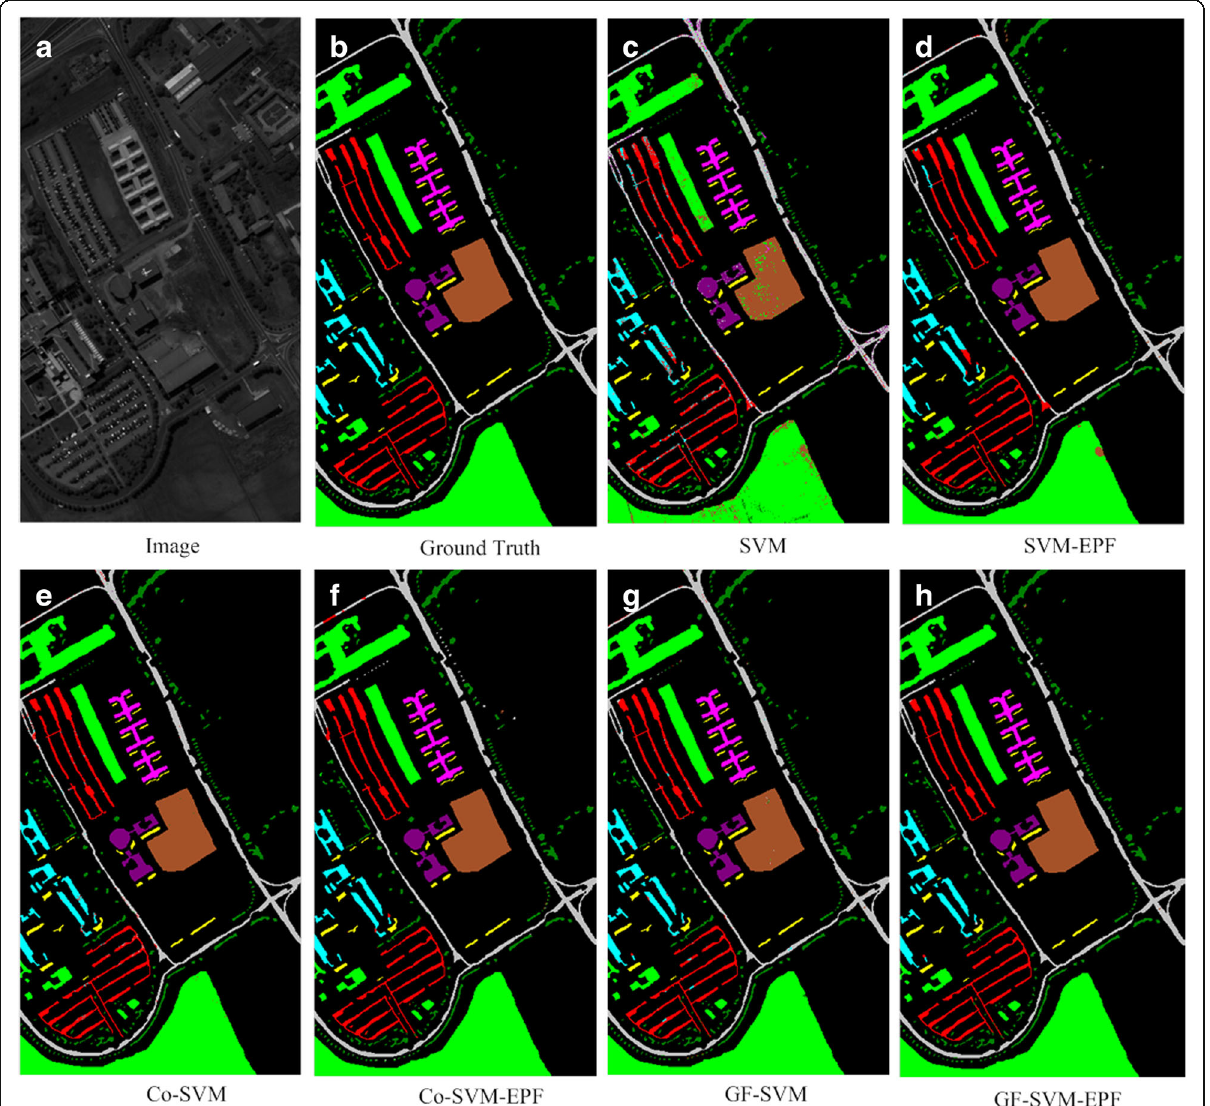
Fig. 3 Qualitative results on the University of Pavia dataset. a Image. b Ground truth. c SVM. d SVM-EPF. e Co-SVM. f Co-SVM-EPF. g GF-SVM. h